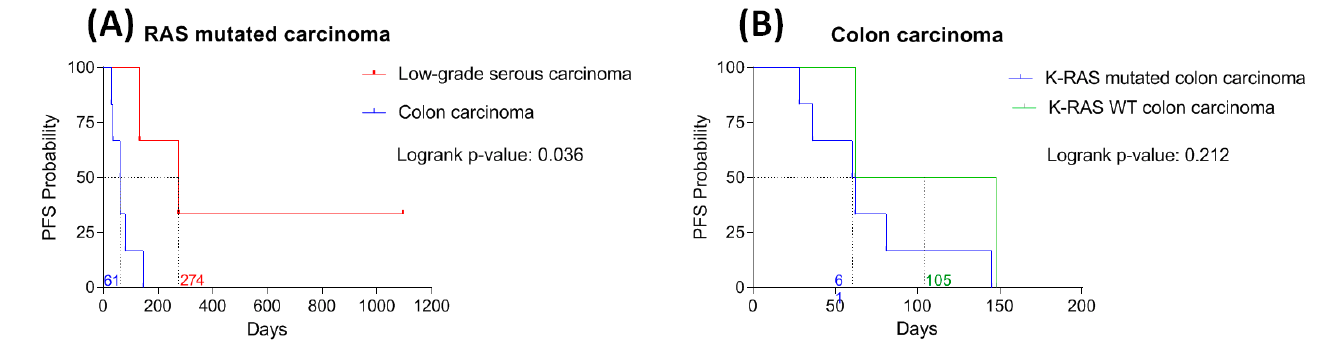
Figure 4. Association between histology and/or RAS mutational status and progression-free survival (PFS). ( A ) Kaplan-Meier survival curves for PFS according to histology in RAS mutated carcinoma. ( B ) Kaplan-Meier survival curves for PFS according to RAS mutational status in colon carcinoma. Secondly, we wanted to know what proportion of patients with serous carcinoma had RAS / RAF mutations. In our anticancer center, 129 patients with serous carcinoma benefited of whole exome analysis by next-generation sequencing of the tumor. Among